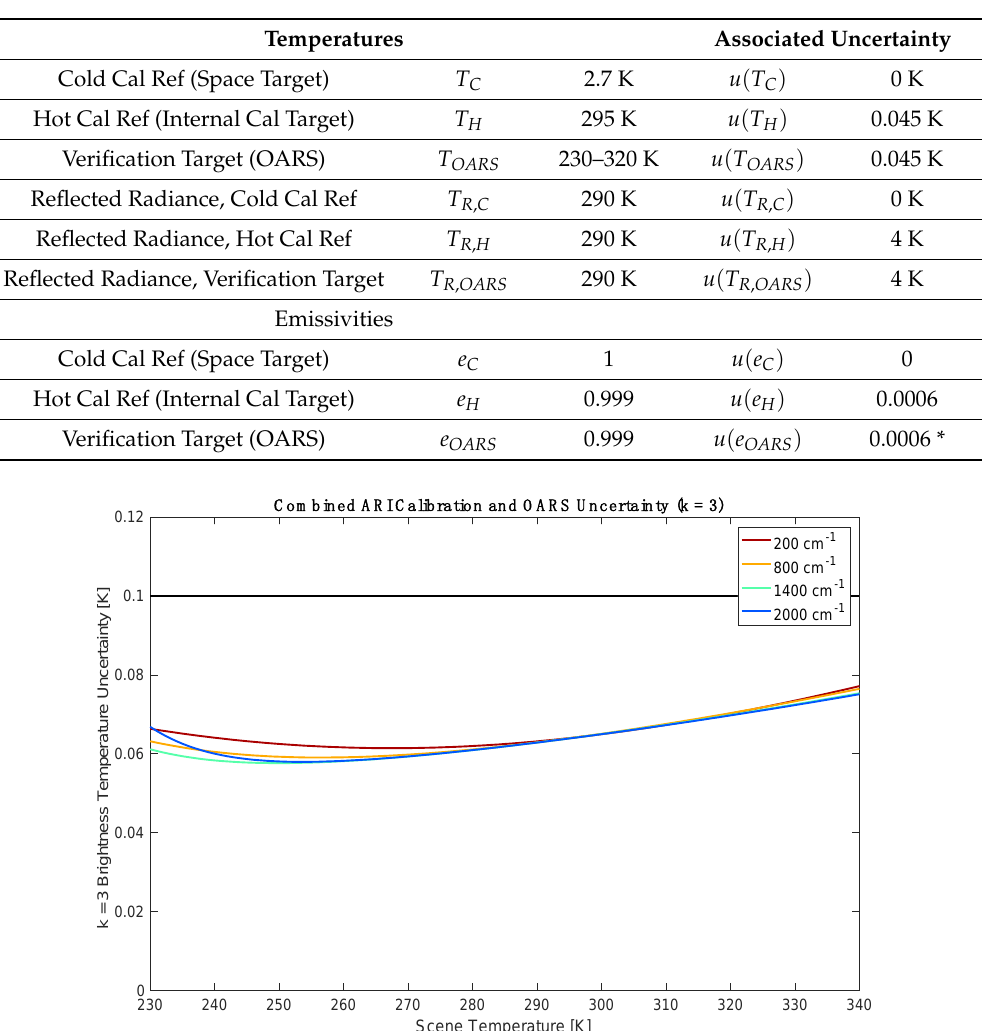
Table3. Uncertaintyestimatesusedintheradiometricuncertaintyanalysisfortheon-orbitconfiguration. All specified uncertainties correspond to a k = 3 coverage factor. The temperature uncertainty for the OARS is explained in Section 5. For the flight sensor, it has been assumed that the OARS emissivity and associated uncertainty are determined from laboratory testing with a very high emissivity source.